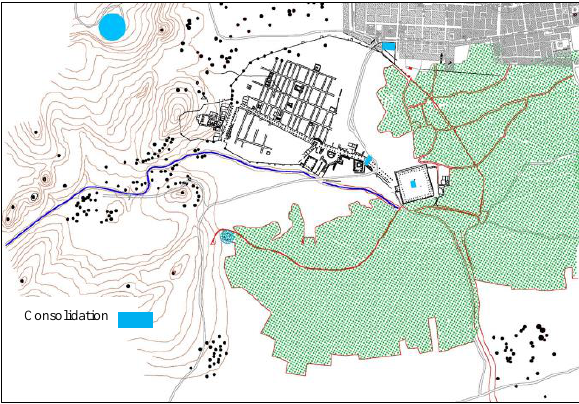
Figure (35) the proposed outline of the ambulatory consolidation